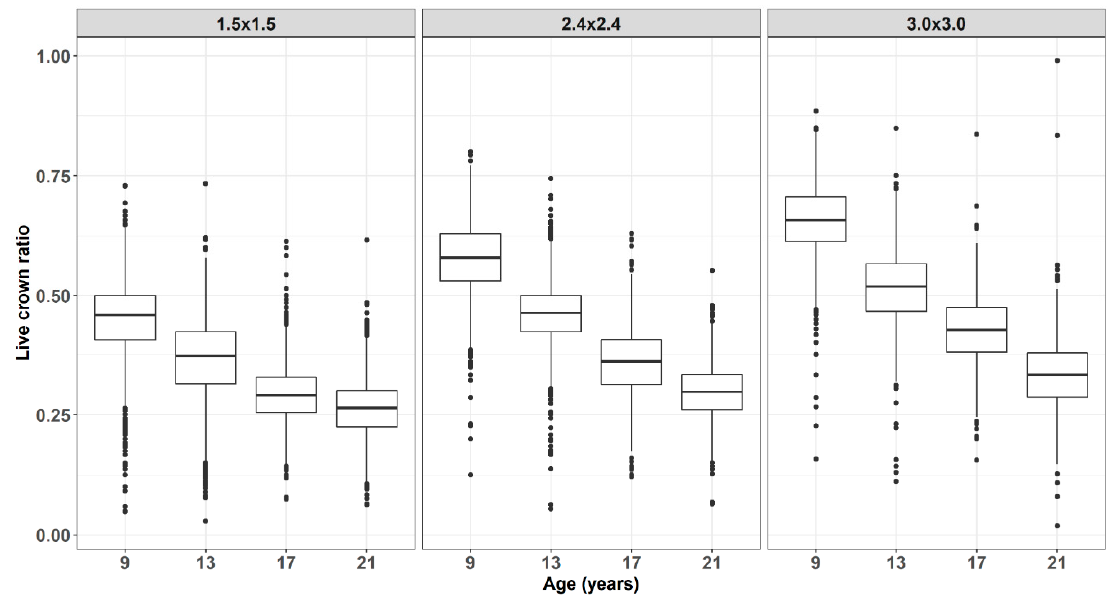
Figure 3. Boxplot of live crown ratio by age for different levels of initial plantation